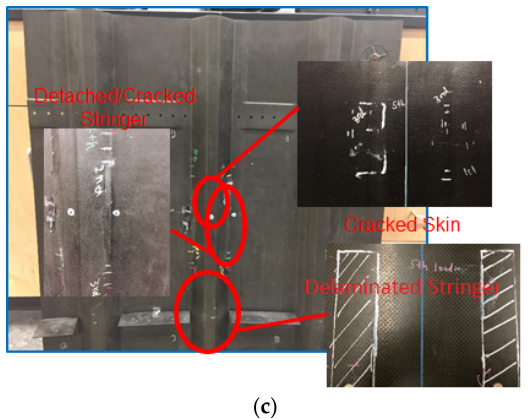
Figure 1. Test specimens: ( a ) Panel 1: five stringers, three C-frame panels with cracked skin, and a cracked stringer; ( b ) Panel 2: four stringers, three C-frame panels with a disbonded/detached stringer; ( c ) Panel 3: three stringers, two C-frame panels with cracked skin, a detached/cracked stringer, and a disbonded stringer.